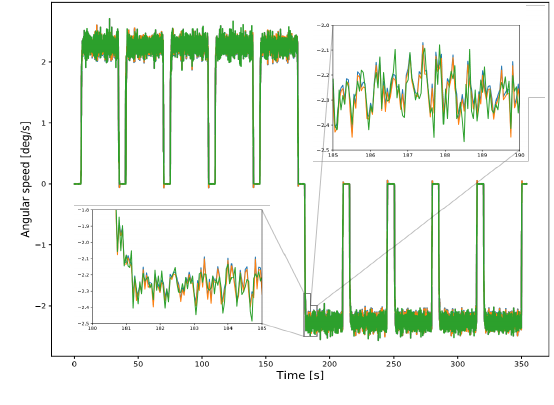
Fig. 8. Angular velocity comparison.